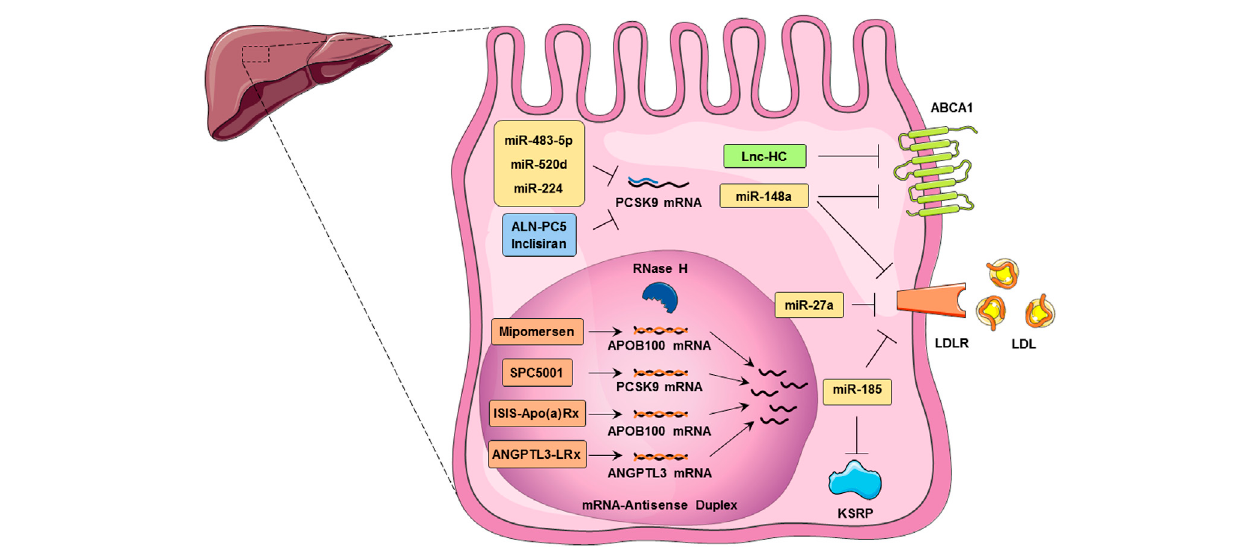
FIGURE 1 | Noncoding RNAs regulate cholesterol homeostasis in hepatocytes. These RNAs, including, LncRNAs, miRNAs, ASOs, and siRNAs, control cholesterol accumulation, cholesterol ef fl ux, cholesterol biosynthesis, and cholesterol metabolism. ABCA1 expression is regulated by both Lnc-HC and miR-148a in hepatocytes which leads to cholesterolef fl ux inhibition. MicroRNAs such asmiR-483-5p, miR-520d, and miR-224 inhibit PCSK9 translation. miR-27a and miR-185 are involved in the inhibition of LDLR translation and thus reduce the LDL uptake by hepatocytes. Mipomersen, ISIS-Apo(a)Rx, and ANGPTL3-LRx are antisense oligonucleotides that regulate the APOB100 mRNA. SPC5001 induces the degradation of PCSK9 mRNA in the nucleus of the hepatocytes. Inclisiran, an approved siRNA, and ALN-PC5 inhibit the translation of PCSK9 in the cytoplasm of hepatocyte and hence LDLR